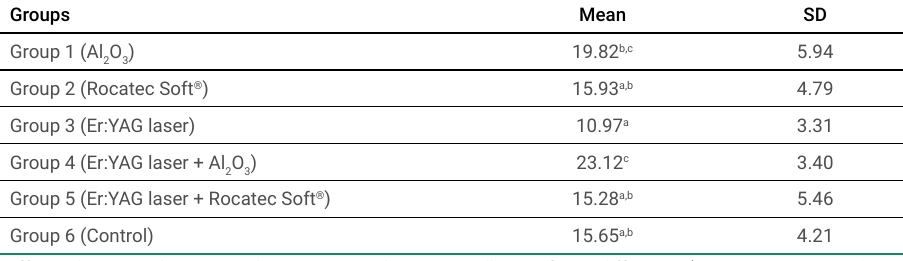
Table 1. Mean shear strength (in MPa) of the groups after surface treatments. Groups